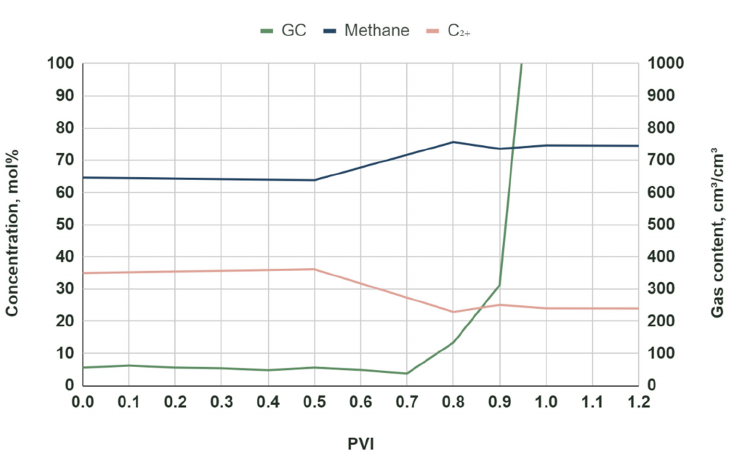
Figure 7. Methane and C 2+ concentration in produced gas, for APG injection at a pressure of 40 MPa.